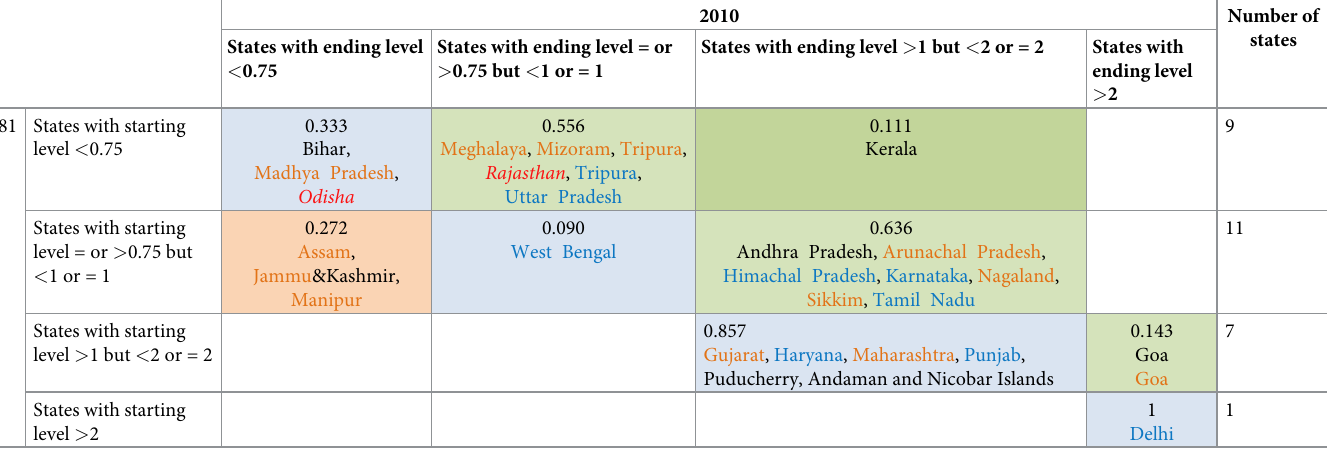
Table 3. Relative per capita income transition dynamics,